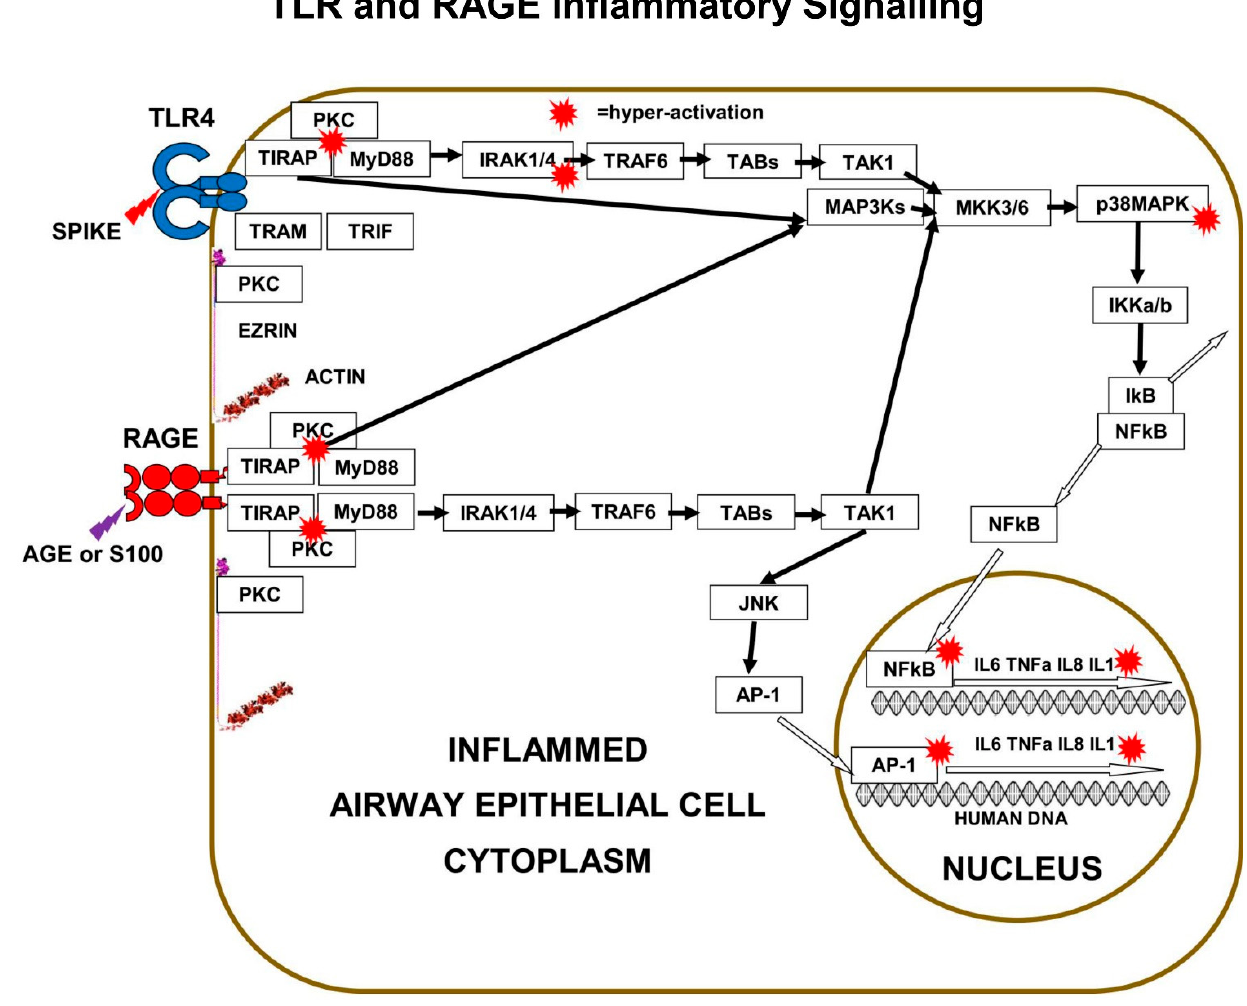
Figure 3. As COVID-19 develops, not only do viral proteins trigger TLRs, but also AGEs and S100 proteins from damaged tissues trigger RAGE, resulting in amplification of pro-inflammatory sig-